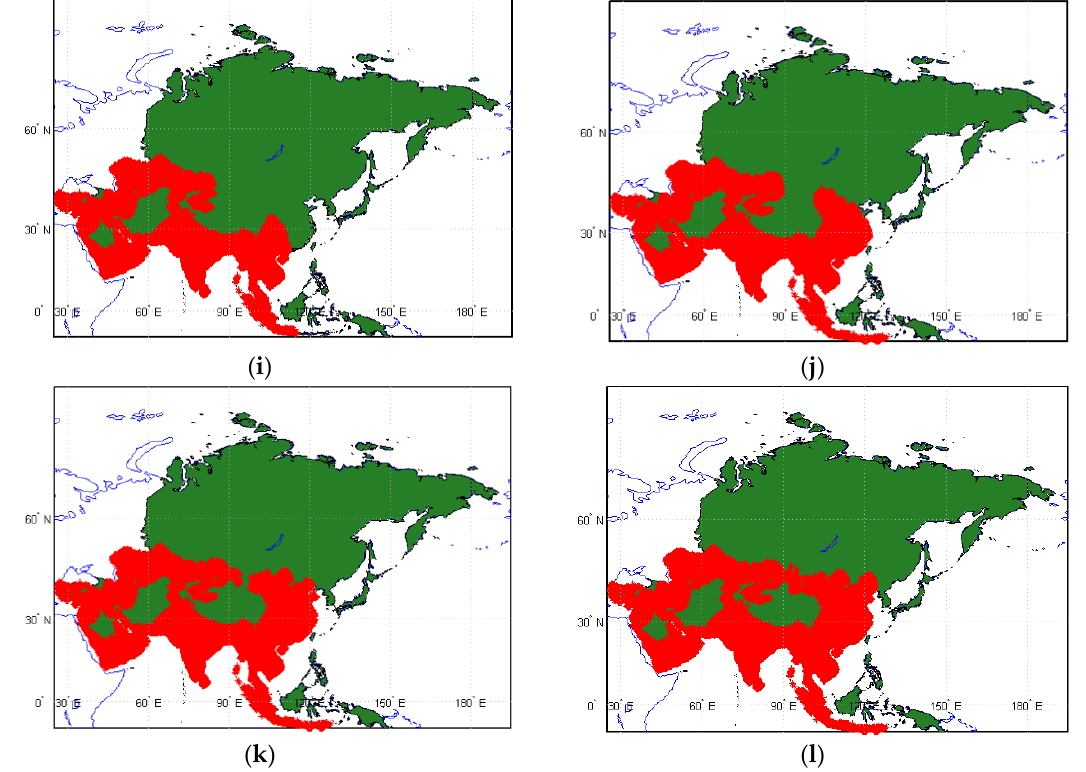
Figure 2. The invasion of Tuta absoluta in Asia. The simulation is made for 25 years considering the temperature and relative humidity as parameters. Locations in green are those susceptible to being invaded; locations in red are those invaded by the spread of T . absoluta . (a) 1 Year; (b) 4 Years; (c) 6 years; (d) 8 years; (e) 10 years; (f) 12 years; (g) 15 years; (h) 17 years; (i) 19 years; (j) 21 years; (k) 23 years; (l) 25 years.